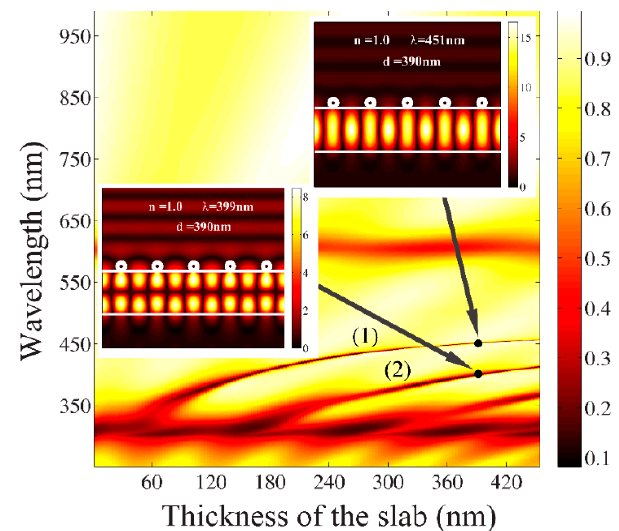
Figure 7. Plasmonic grating as refractive index sensor: Contour plots of transmission spectra versus thickness of the slab d at n = 1. Simulated near field distributions of | H z | at λ = 451 nm and λ = 399 nm for a fixed thickness of the slab d = 390 nm are shown as insets.